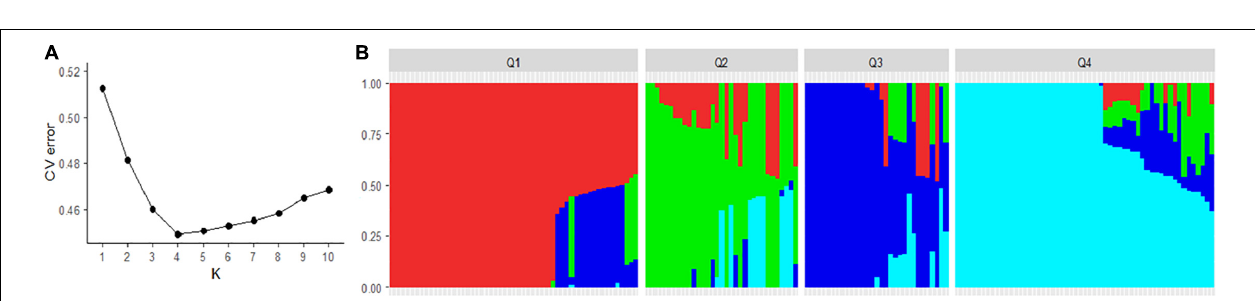
FIGURE 3 | Population structure of the spinach panel generated from the ADMIXTURE run. (A) Optimum K was determined using the minimum cross-validation errors in the data for K. (B) Classification of spinach lines in the association panel into four genetic sub-population. The horizontal axis represents the spinach lines, and the vertical axis of the plot represents the probability of genotypes belonging to different genetic groups. Spinach lines membership proportion to each population group is indicated by a unique color, red (Q1), green (Q2), blue (Q3), and turquoise (Q4).